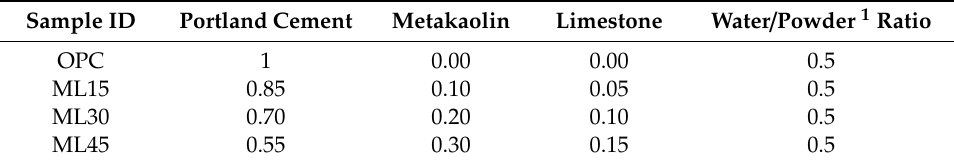
Table 3. Mixture proportion of the samples expressed as mass ratio.